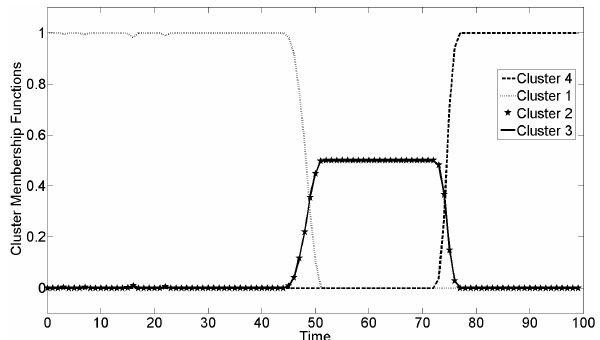
Figure 4. Cluster membership functions for synthetic data when K = 4; µ(t) for the first and fourth clusters are about 0 or 1 and thus these clusters are found correctly, but µ(t) for the second and third clusters are equal to about 0.5 in time domain [50, 75] and 0 elsewhere. This means that clusters two and three are not separable and that K must be decreased from 4 to